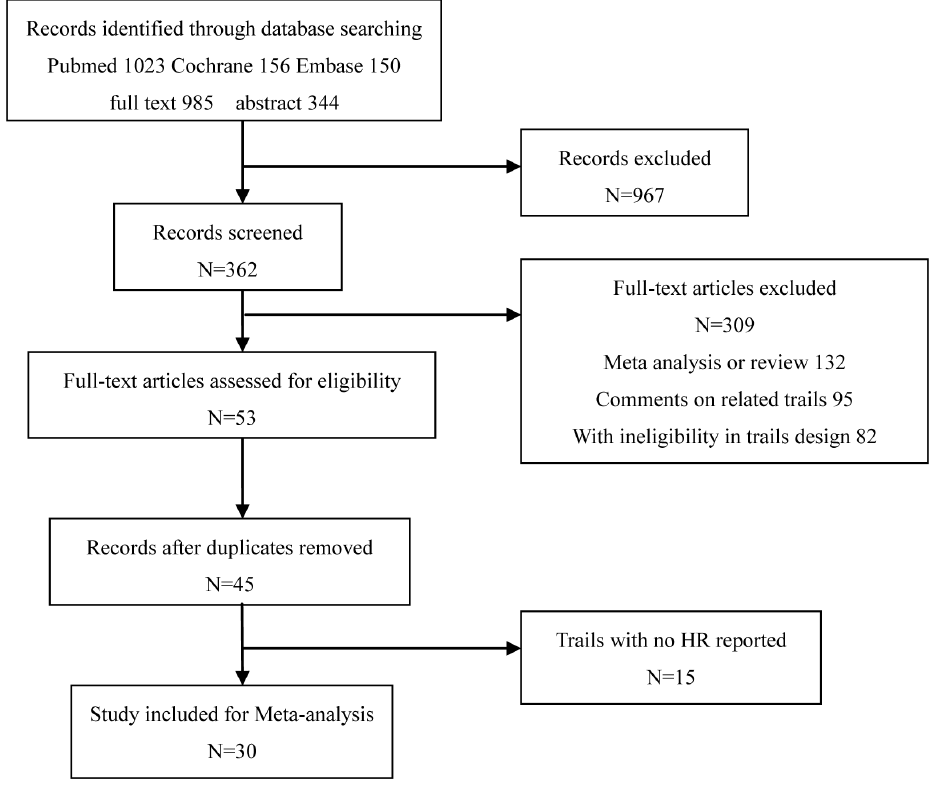
Figure 1. Flow chart showing the progress of trials through the review.